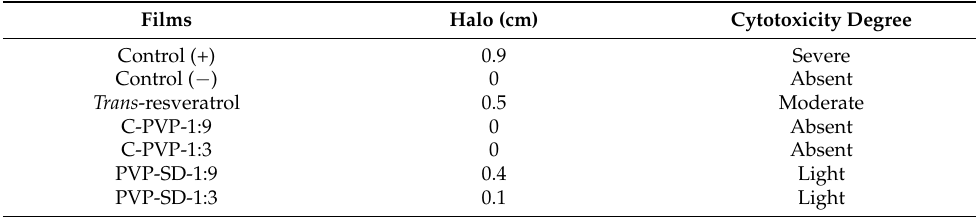
Table 7. Qualitative results of cytotoxicity study.